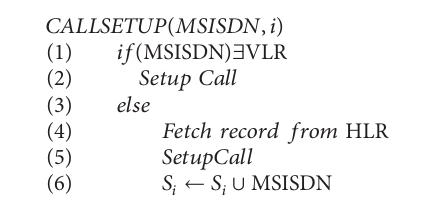
Algorithm 1: Call setup process.